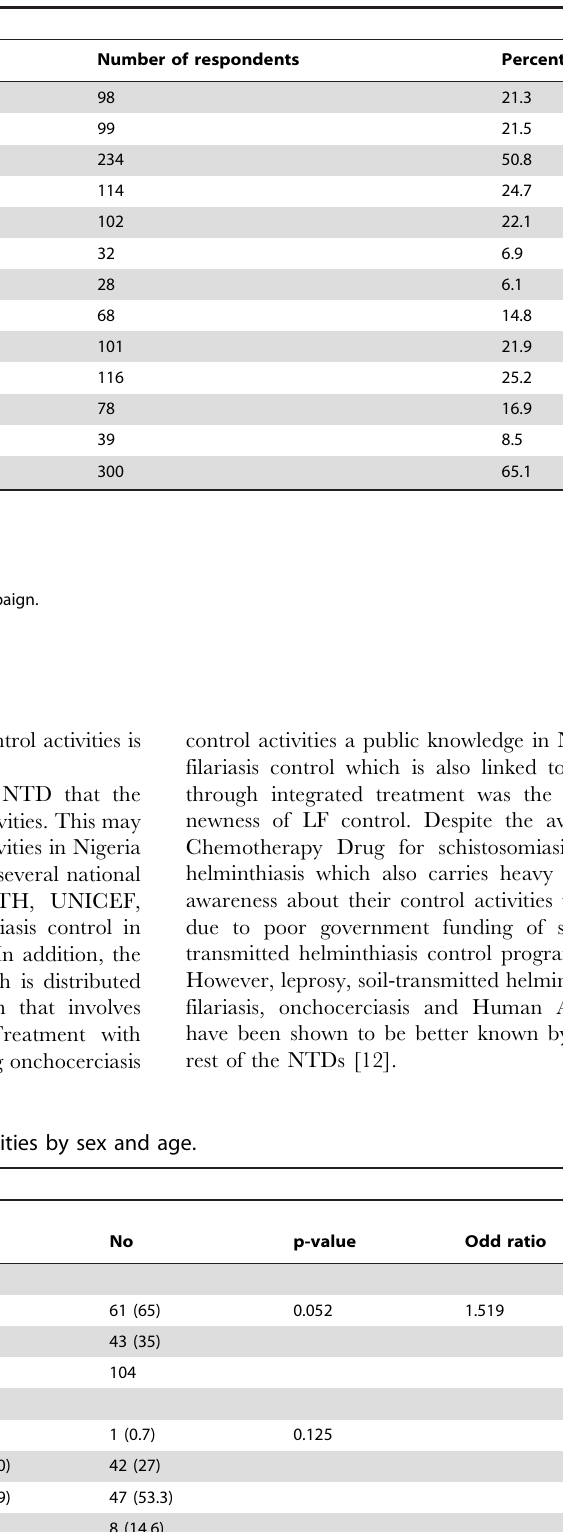
Table 3. Knowledge of respondents about specific NTDs control activities.